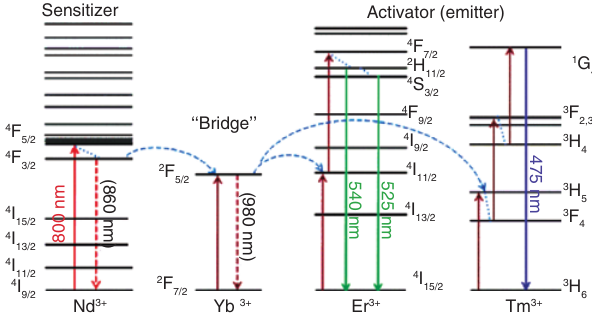
Figure 7: Upconversion process of Nd 3 + → Yb 3 + → Er 3 + (Tm 3 + ) tridopants system with 800 nm excitation.